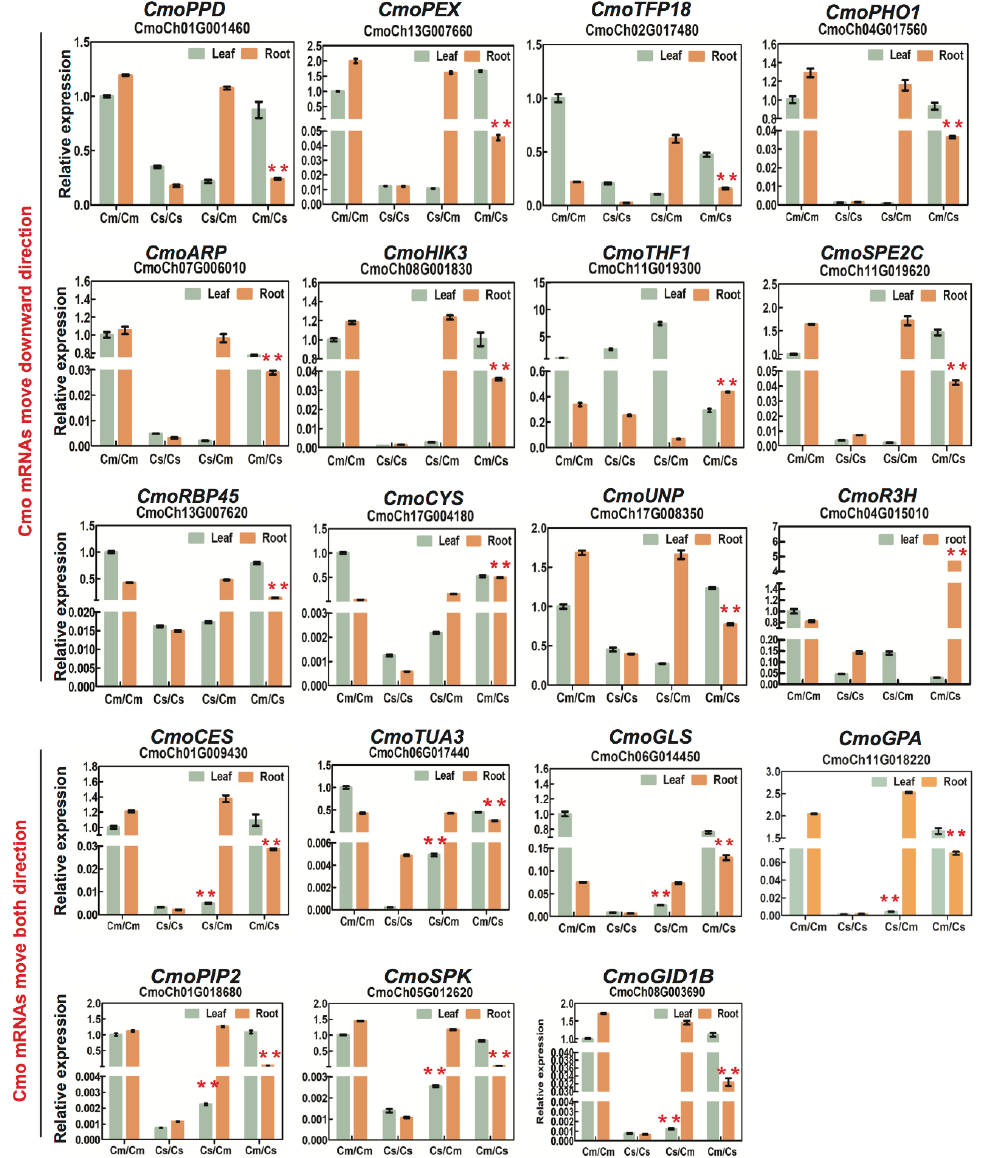
Figure 8. RT-qPCR verification of selected Csa mRNA mobility and movement direction in heterografts. Csa / CmoACTIN7 was used as an internal reference for heterograft Cmo and Csa samples. Specific primers recognizing Csa transcriptswereusedforRT-qPCR,whichidentifiedanextremelylowmRNAabundance in control Cmo / Cmo homografts. A significant increase in mRNA abundance in Csa / Cmo root and Cmo / Csa shoot suggested potential downward and upward bidirectional movement of Csa mRNA. Graphs were generated by GraphPad Prism5.0. Red asterisks indicate highly significant di ff erences from the same tissue of homograft controls using t -test for independence of variables in a contingency table. Cs, Cucumis sativus ; Cm, Cucurbita moschata